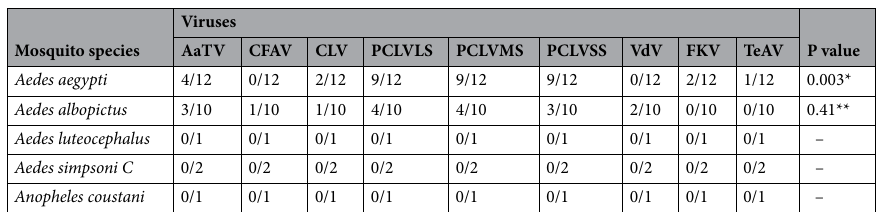
Table 1. Distribution of the viruses based on the species of mosquitoes. AaTV Aedes aegypti totivirus, CFV cell fusing agent virus, CLV Chaq-like virus, PCLP Phasi Charoen like phasivirus (L segment, M segment,